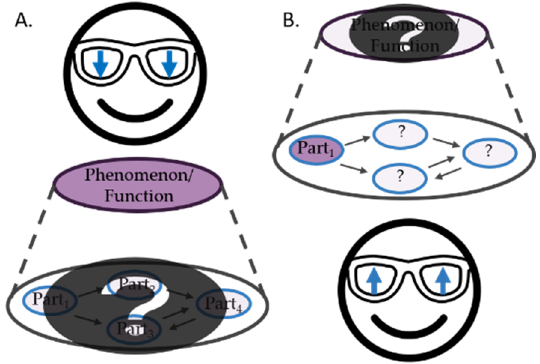
Figure 1. Illustrating the differences between upward looking and downward looking approaches to research. Panel ( A ) represents the downward looking approach, e.g., decomposition. Panel ( B ), represents the upward looking approach, e.g., composition or